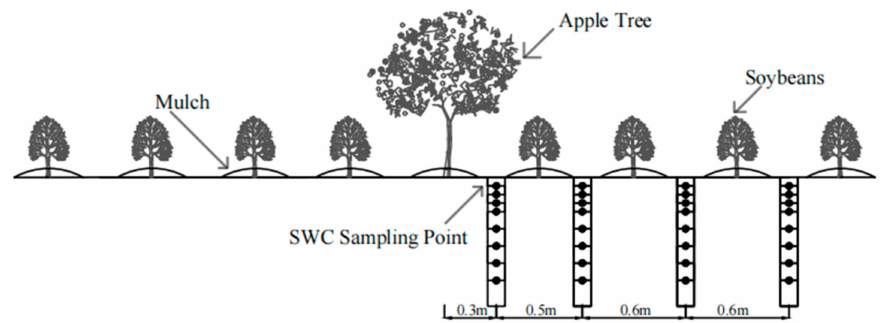
Figure 3. Soil moisture monitoring point layout.